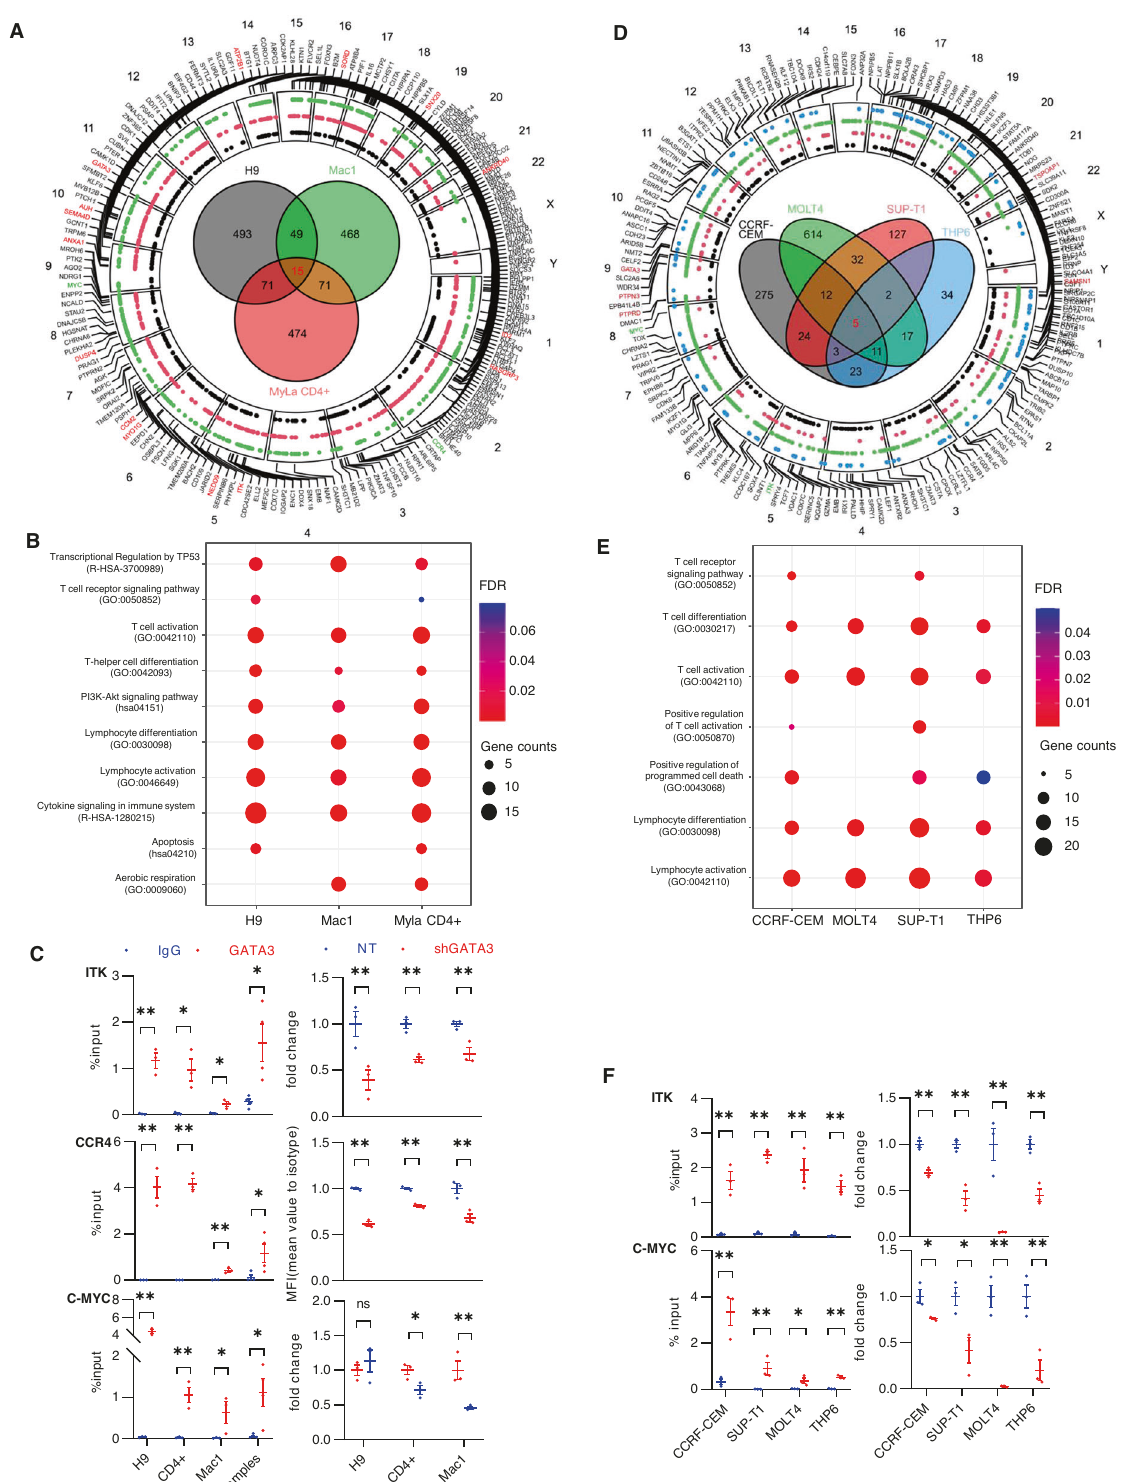
Supplemental Table 1). Consistent with prior studies [1, 2], GATA-3 expression was associated with a signi fi cant reduction in both event-free (Fig. 1J) and overall survival (Fig. S1H). A signi fi cant difference in survival between GATA-3 PTCL patients receiving the current standard of care in the frontline setting (i.e., an